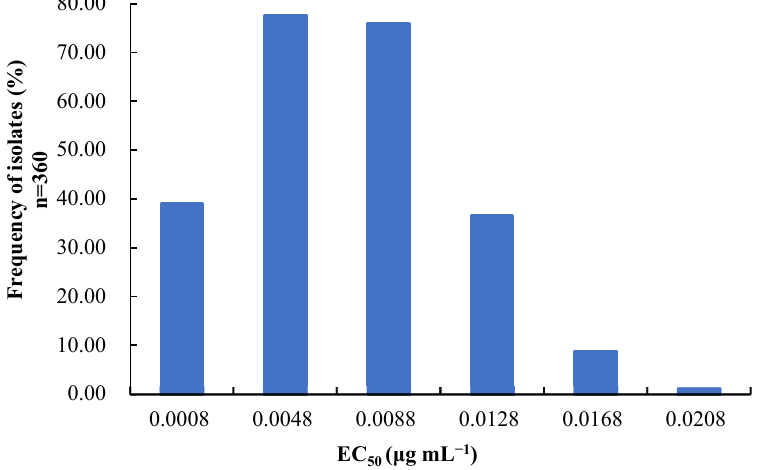
Figure 3. Frequency distribution of sensitivity (baseline sensitivity) of SYP-32497 to R. solani.